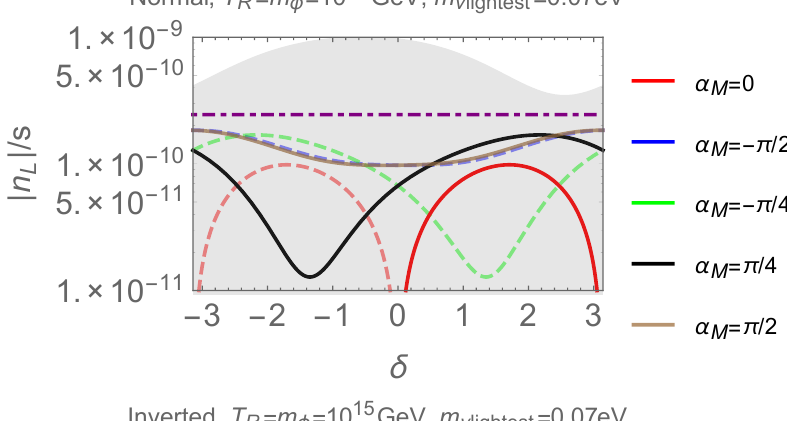
1.010 - 4 - 4.0 - 3.5 - 3.0 - 2.5 - 2.0 - 1.5 -